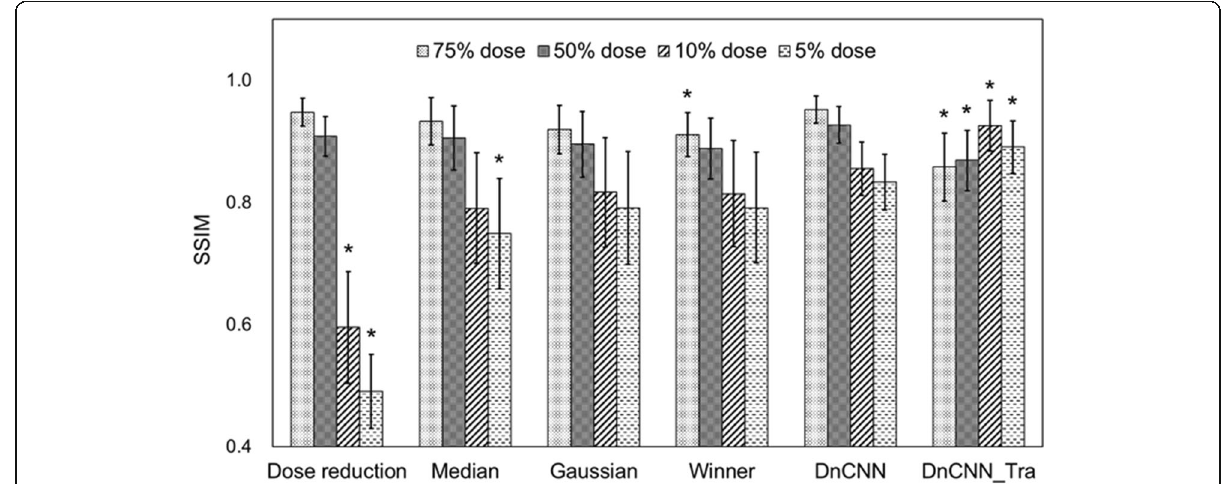
Fig. 6 SSIM results for different noise-reduction methods for each dose-reduction simulated image. * indicates p < 0.05, which represents a significant difference in the SSIM value relative to the results of the original DnCNN method